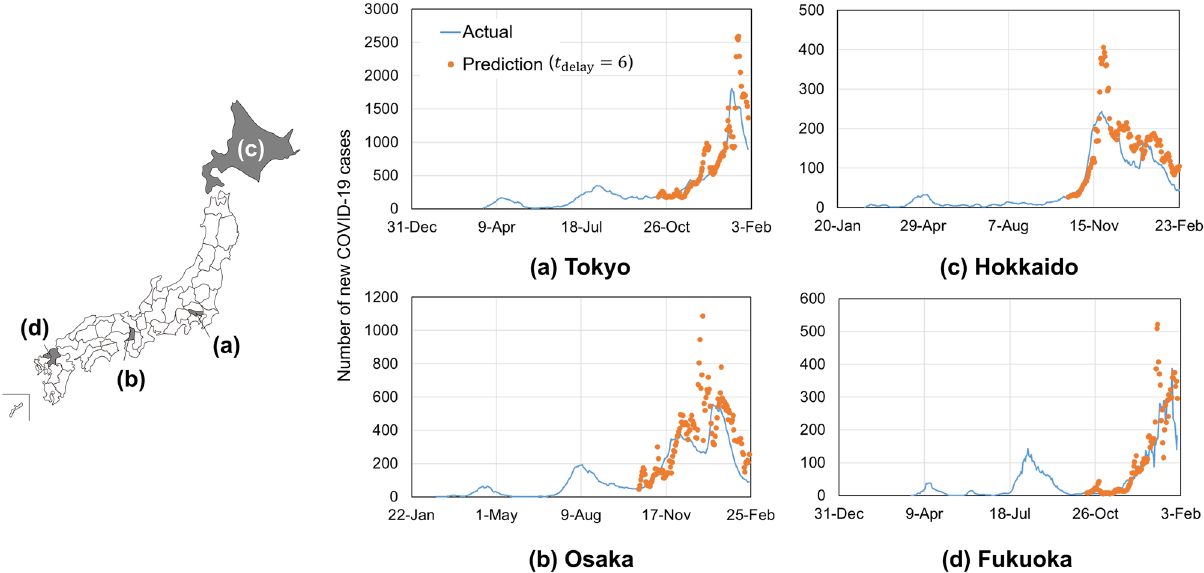
Figure 3. Forecast results of the number of COVID-19 cases in four prefectures in Japan: ( a ) Tokyo; ( b ) Osaka; ( c ) Hokkaido; and ( d ) Fukuoka. The locations of the prefectures are shown in the map at the left. These four prefectures were selected because of geographical differences, their large populations, and the high number of COVID-19